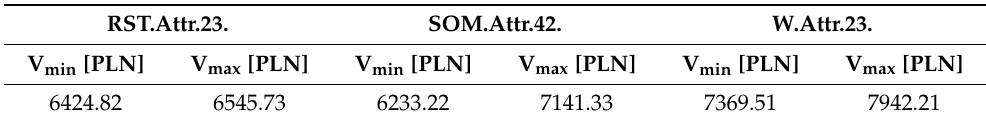
Table 7. Value range for a given homogenous attribute grouping, illustrated using an example homogenous area. Source: own